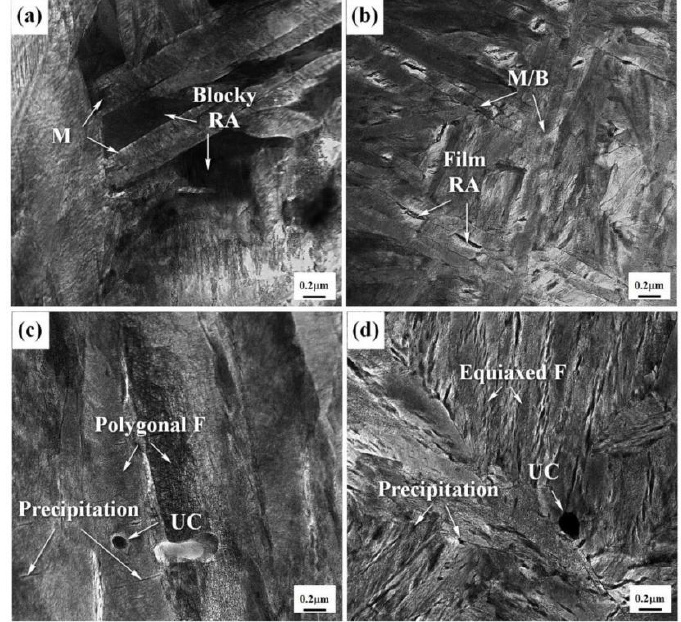
Figure 8. TEM micrographs of the Q-T specimen after ( a ) quenching and ( c ) tempering, and the austempered specimen with CR after ( b ) quenching and ( d ) tempering. (F: Ferrite; UC: Undissolved carbide).